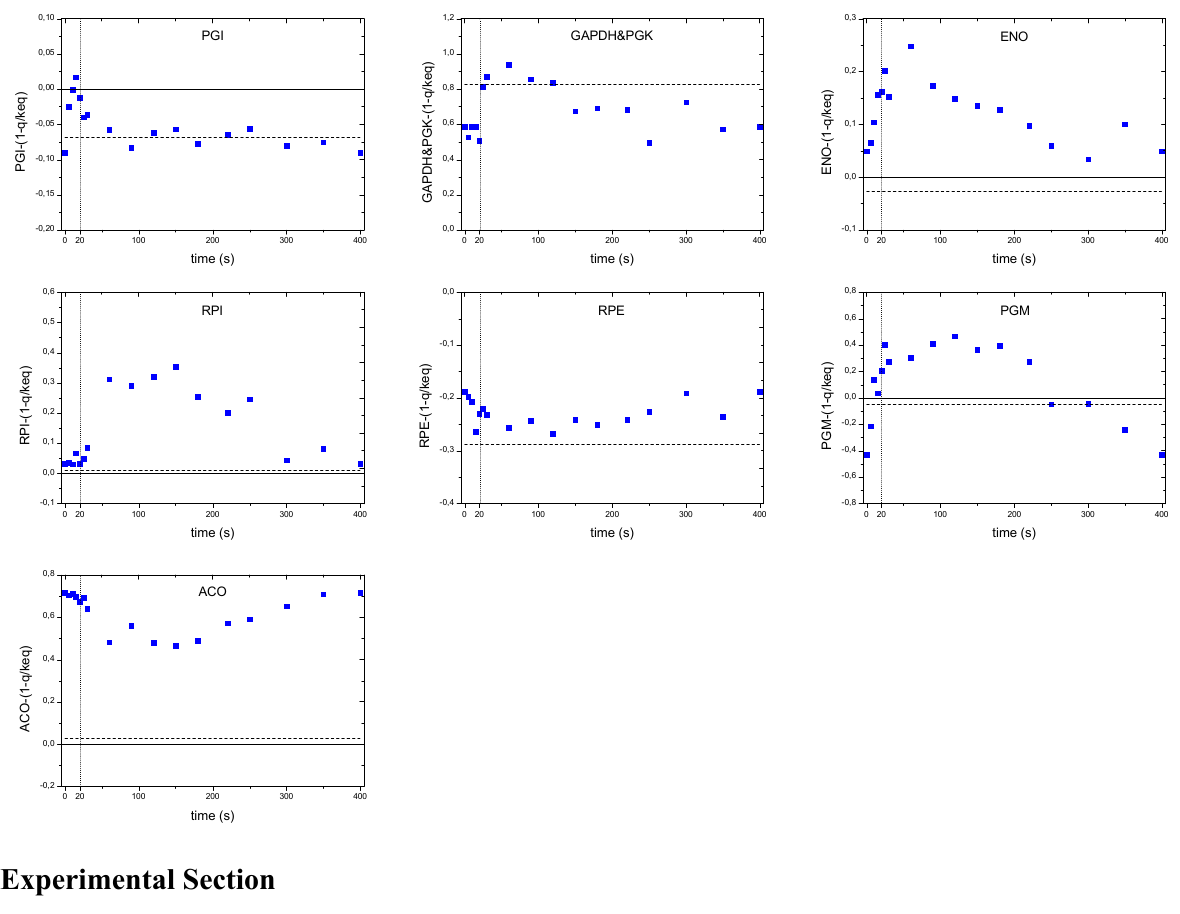
Figure 9. Thermodynamic driving force over the cycle for selected reactions. The dashed line represents the reference steady-state (D = 0.1 h − 1 ). The vertical dotted line represents the end of the feeding